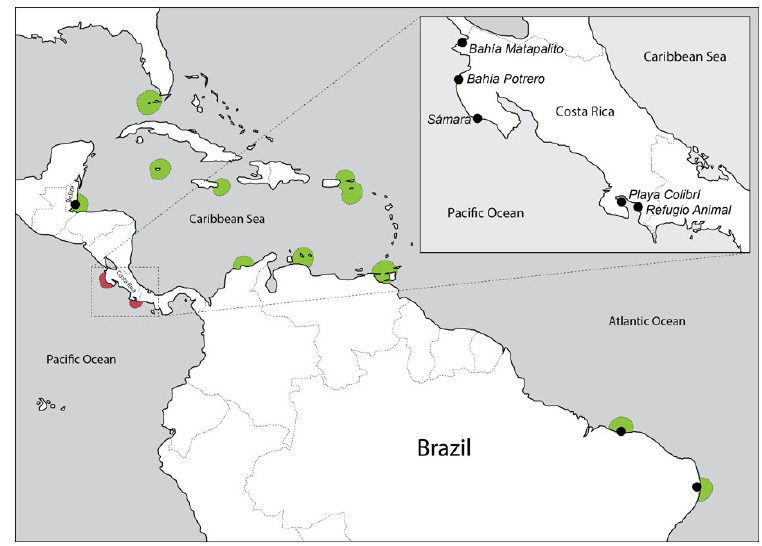
Figure 1. Locations where Halophila baillonii populations have been reported in the Caribbean and Atlantic (Green) [19] and recently in the Eastern Tropical Pacific (Maroon). Sites collected for this study are shown as black dots: Costa Rica (5 sites), Brazil (2 sites), and Belize (1 site). See Table 1 and Supplemental Table S1 for further details on samples from each site. Table 1. Name and origin of Halophila samples used in phylogeny. Additional information can be found in Supplemental S1. * Provided for H. baillonii only.